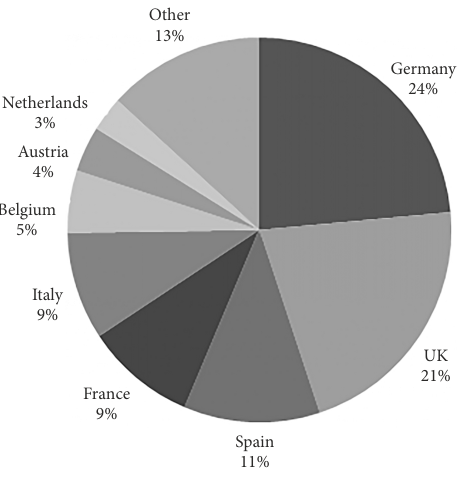
Figure 3. Immigration shares across EU countries (EU-28 except reporting country),